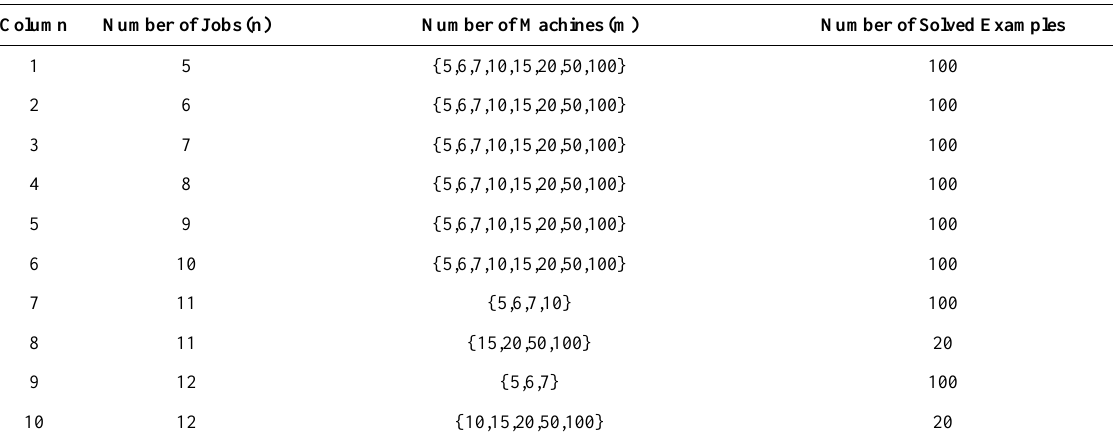
Table 2. The number of solved examples